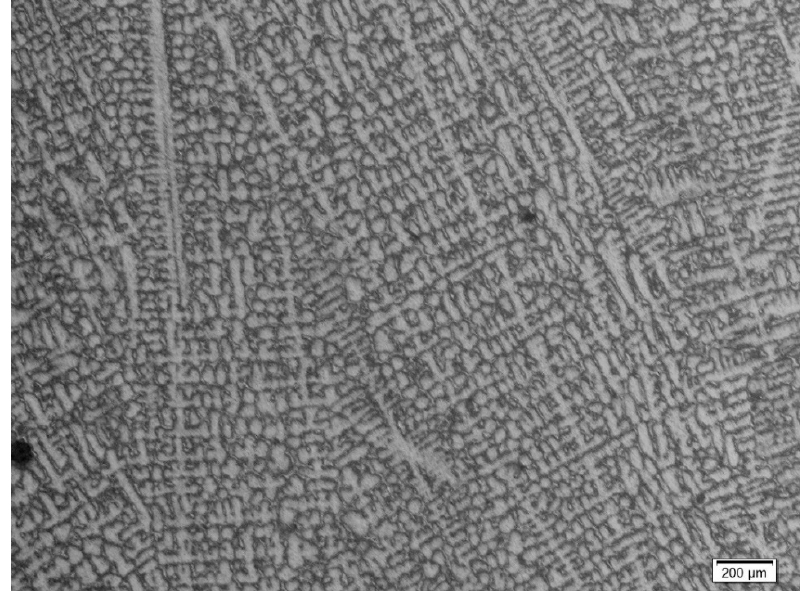
Figure 2. Microstructure of HP-Nb steel with austenite dendritic structure and carbide network in the interdendritic regions.